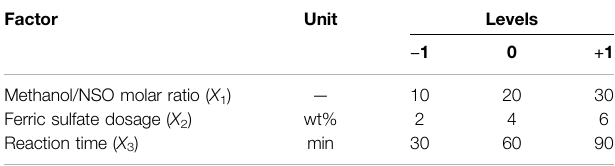
TABLE 1 | Independent factors and levels investigated.